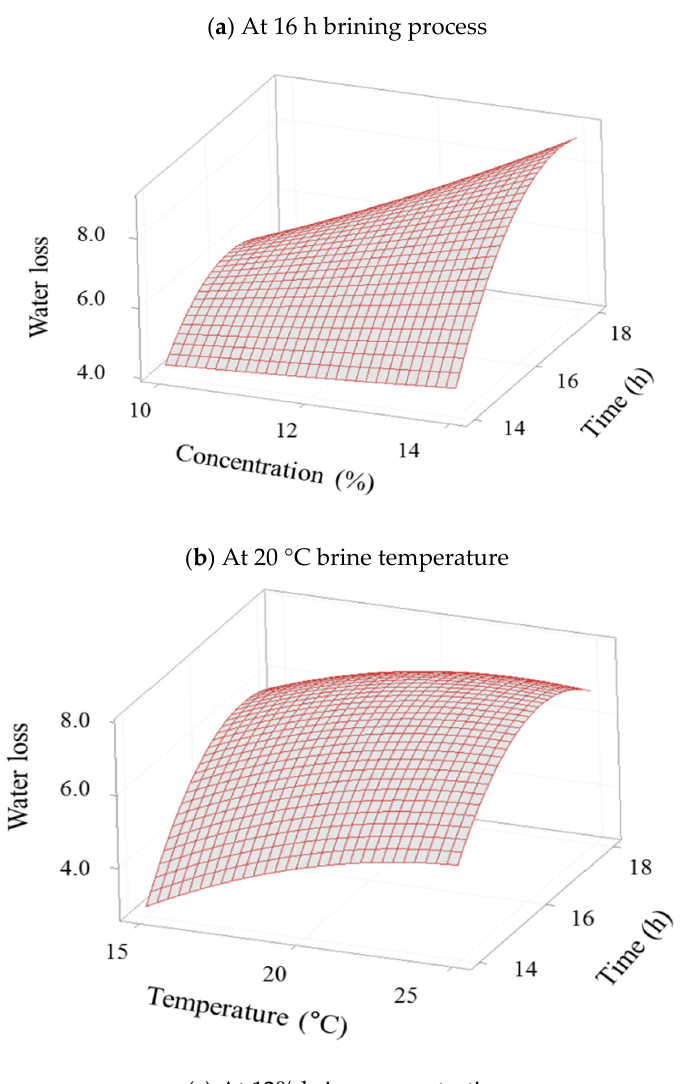
Figure 3. The 3D response surface plots for the water loss during brining process of Kimchi cabbage as a function of ( a ) salt concentration and solution temperature, ( b ) salt concentration and immersion time, ( c ) solution temperature and immersion